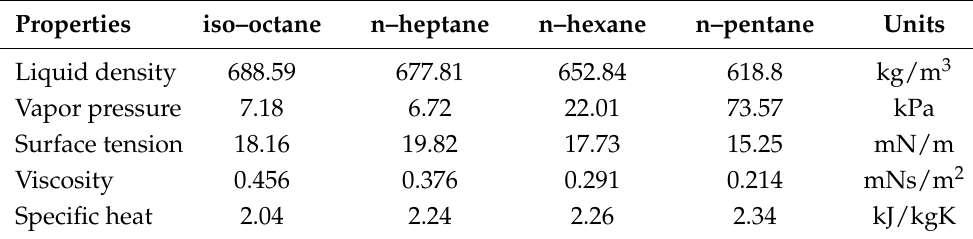
Table 3. Properties of the fuels investigated obtained from NIST database [41].